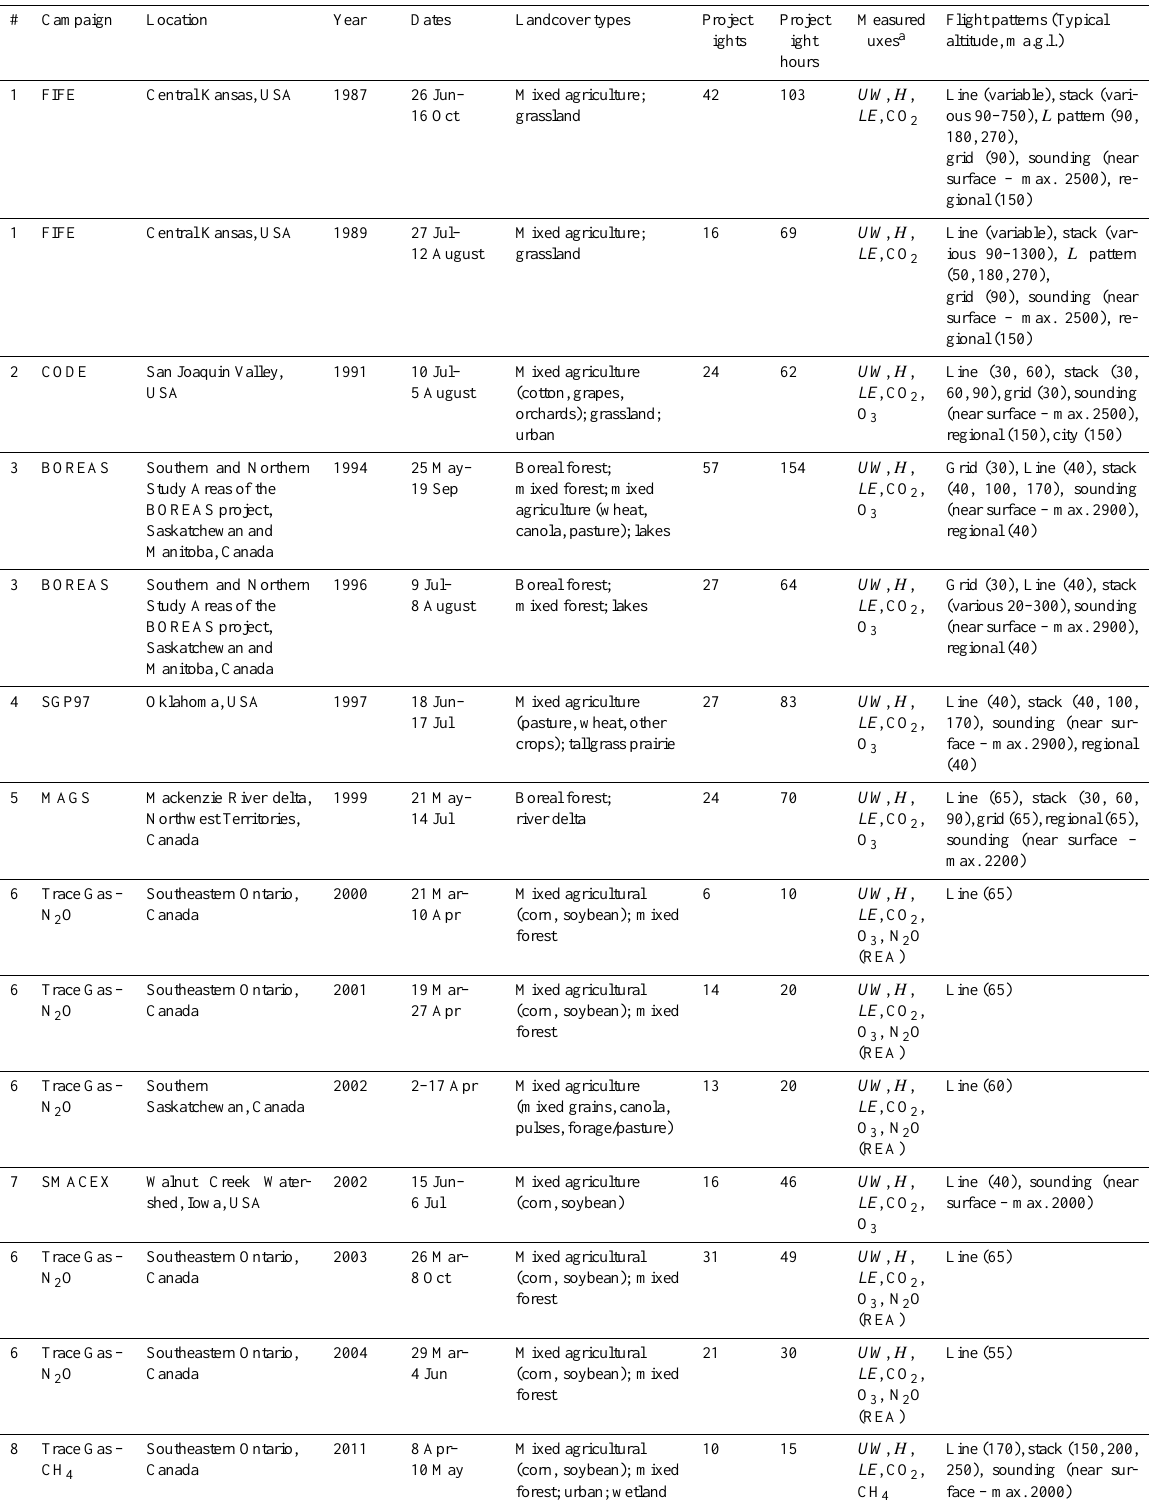
Table 1. Summary of NRC Twin Otter measurement campaigns,